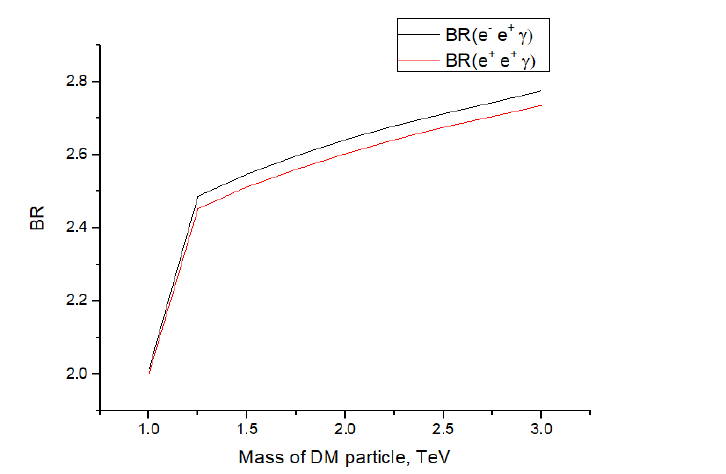
Figure 2. Dependence of Br ( e + e + γ ) and Br ( e + e − γ ) on the mass of the initial particle.